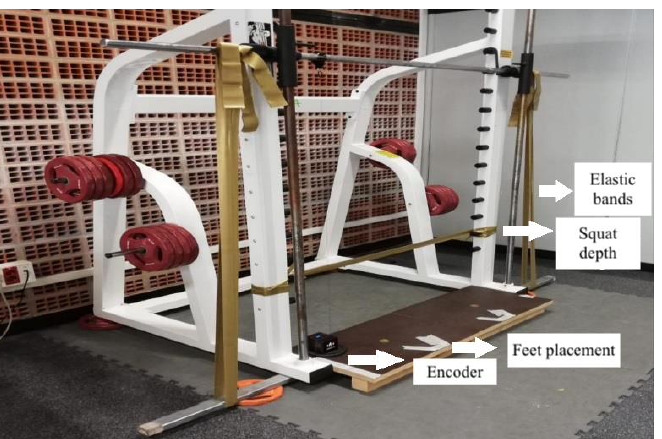
Figure 1. Measurement setting. Smith machine used to perform parallel squats with elastic bands or weight plates. In this case, it is shown its use with elastic bands.